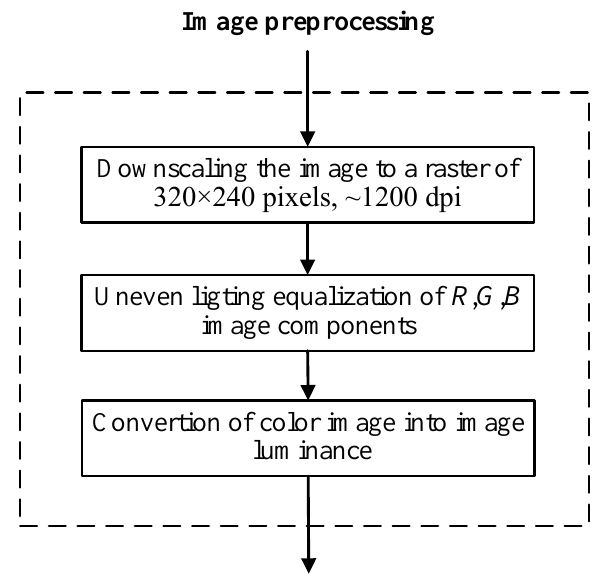
Figure 6. Flowchart of the image preprocessing stages.